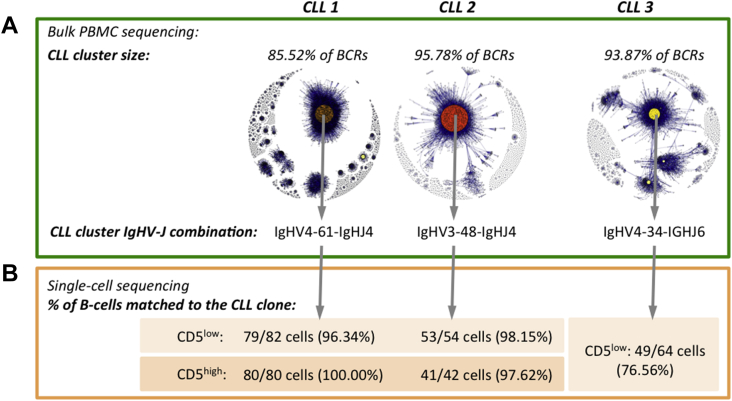
Comparative analysis of CD5high and CD5low B-cell populations in CLL patients and healthy individuals. (A) Bulk-cell total PBMC BCR sequencing networks for CLL patients 1-3 with corresponding maximum cluster sizes and IgHV-J gene usage. Samples yielded 112,722, 222,801, and 151,777 BCR sequences for CLL patients 1, 2, and 3, respectively (after filtering for Ig similarity, length, and primer sequences removal according to Bashford-Rogers et al. [14]). Sequencing networks are presented such that each vertex represents a unique BCR sequence in which relative vertex size is proportional to the number of identical sequence reads. Edges were generated between vertices that differed by single-nucleotide, non-indel differences and clusters were collections of related, connected vertices. The largest cluster sizes (CLL clusters) and corresponding IgHV-J combinations are indicated above and below the networks, respectively. (B) Single-cell analysis of CD5high or CD5low B-cell populations: single-cell BCR sequencing of CD5high and CD5low B cells from CLL patients 1, 2, and 3 was used to determine the frequencies of CLL cells in each B-cell subset. The number and percentage of CD5high or CD5low B cells expressing BCRs matching (i.e., maximum of 3 bp difference from the dominant CLL BCR sequence) the CLL clone for each CLL patient are indicated.